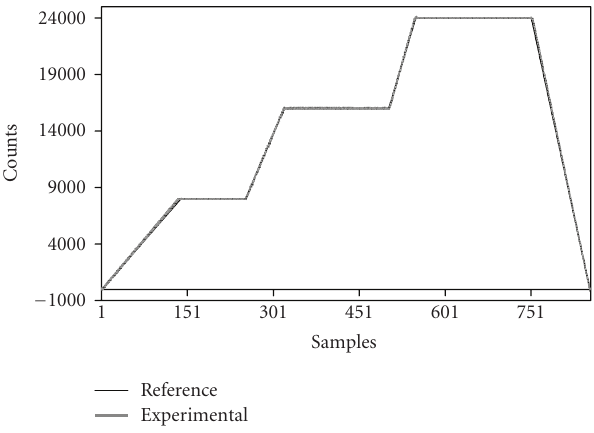
Figure 5: Experimental results for trapezoidal motion II.